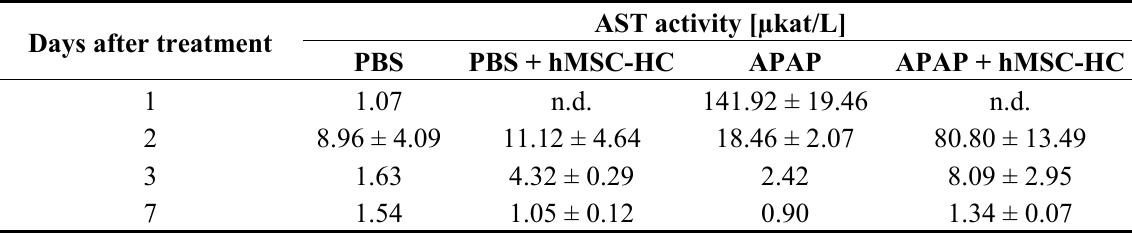
Table 1. Time-dependent increase in aspartate aminotransferase (AST) activity in the serum of mice treated with 735 mg/kg acetaminophen (APAP). AST activity [µkat/L] Days after treatment PBS PBS + hMSC-HC APAP APAP + hMSC-HC 1.07